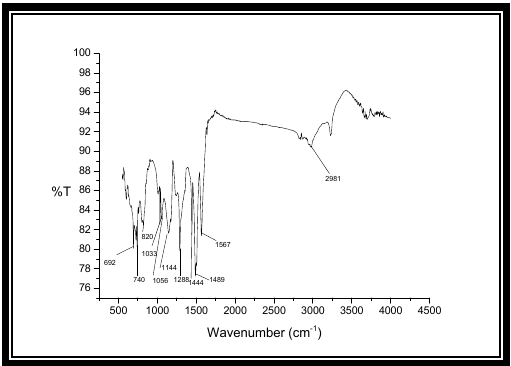
Figure 2. FTIR Spectra of the PNB adsorbent.